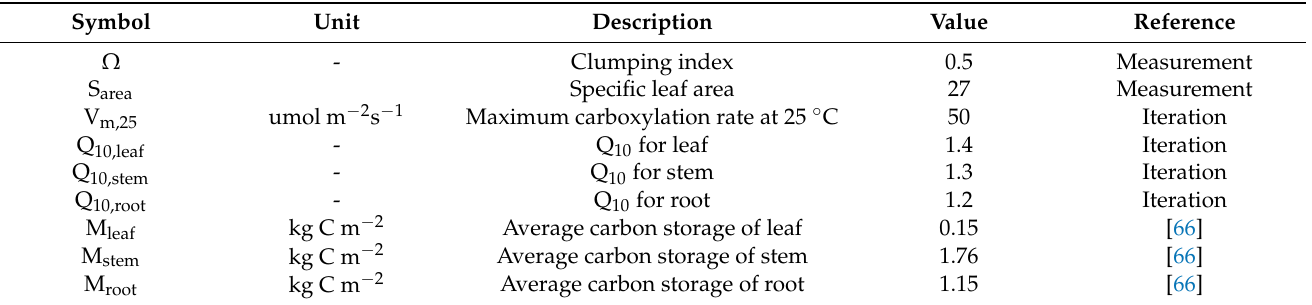
Table 3. Major biological parameters used as inputs into the BEPS model for simulating the CO 2 fluxes of bamboo